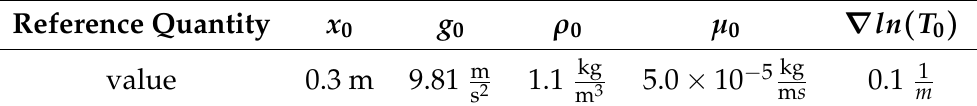
Table 1. Reference values used to determine non-dimensional